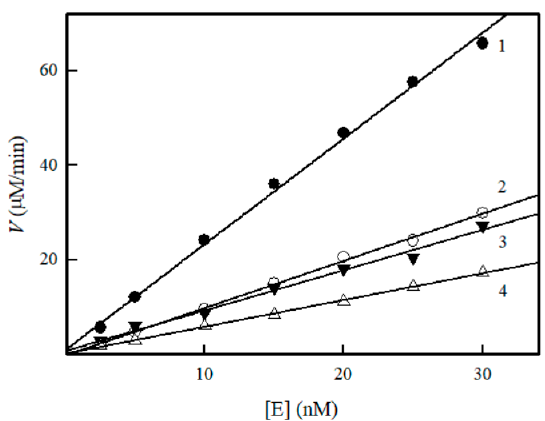
Figure 4. Dependence of NADPH oxidation rate on NfsA concentration in the absence (1,3) or presence (2,4) of 2.0 mM ascorbate. NADPH concentration, 200 µM, 50 µM TNT (1,2) or 2.0 mM p -nitrobenzoic acid (3,4) were used as oxidants.